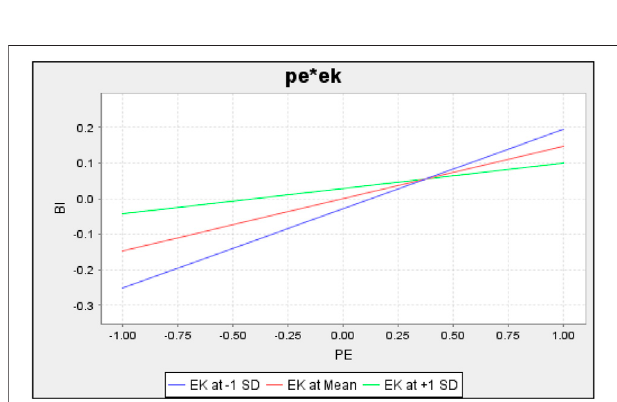
Table 7 . Results revealed that Environmental knowledge